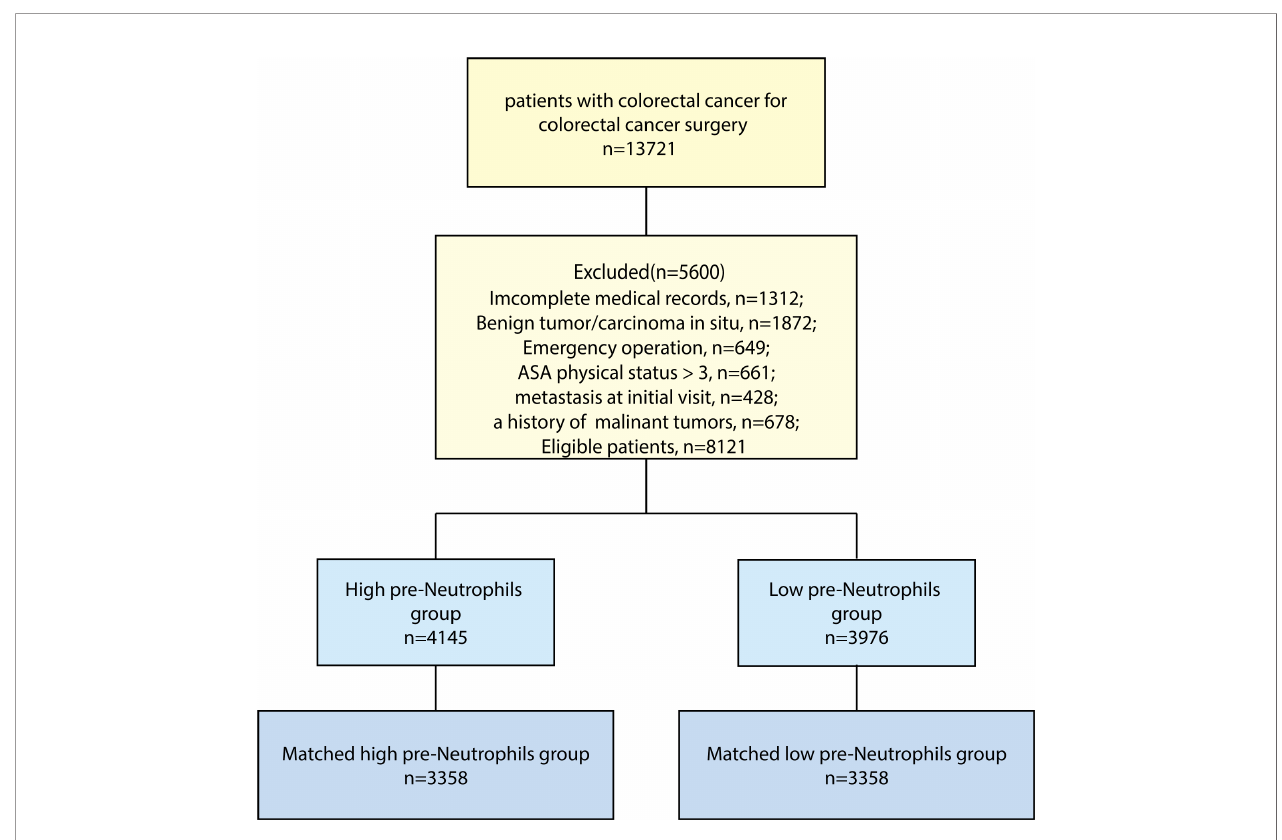
FIGURE 6 | Flow chart of patient selection. Flow chart of patient